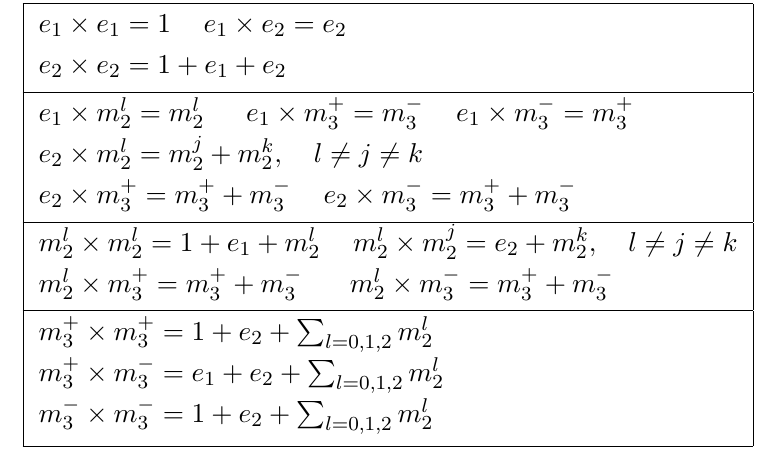
Table 3 . Fusion Rules of D [ D 3 ] [14,